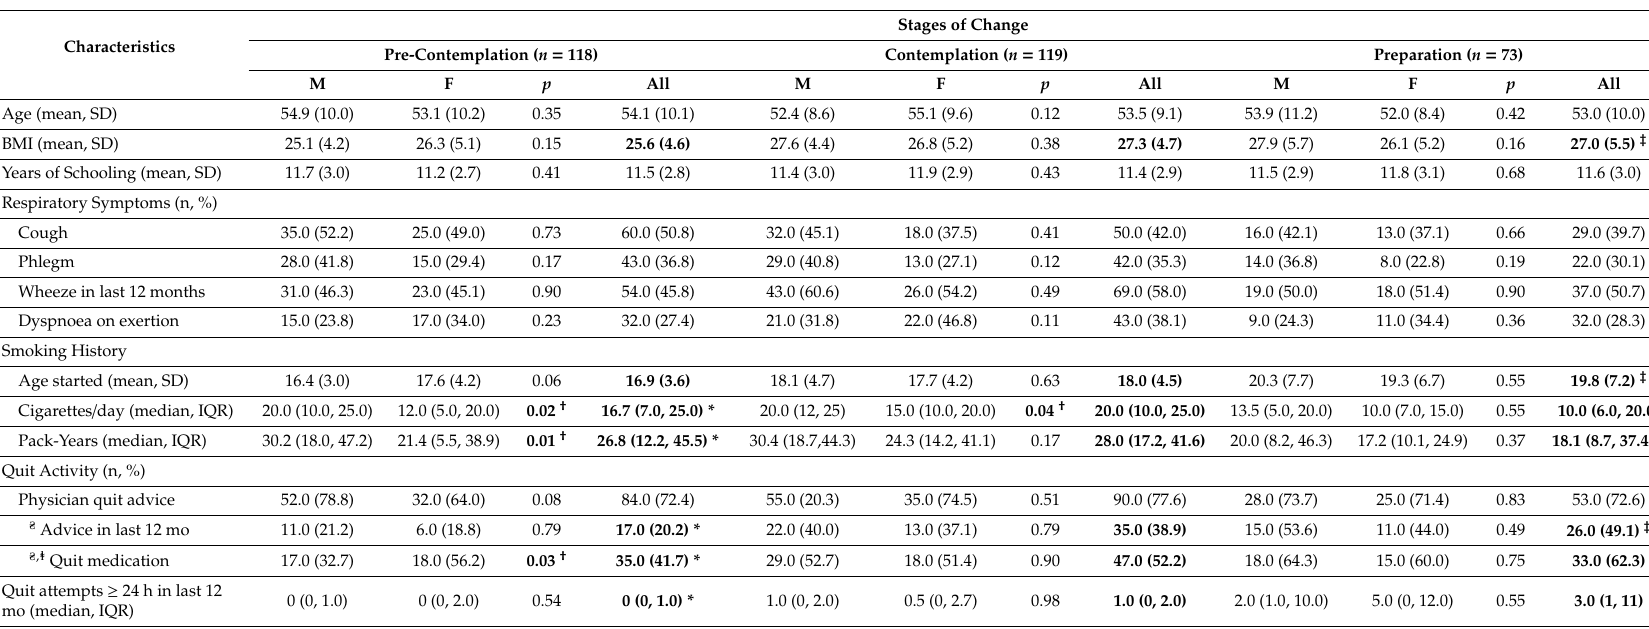
Table 1. Demographics, Respiratory and Smoking Characteristics by Stages of Change and Gender, Burden of Obstructive Lung Diseases (BOLD)-Australia Study. Characteristics Stages of Change Pre-Contemplation ( n = 118) Contemplation ( n = 119)